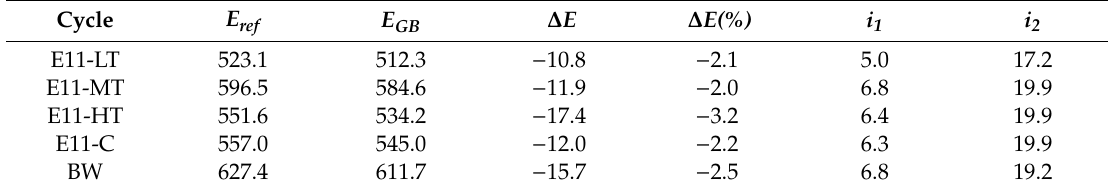
Figure 9. Illustration of optimal gear ratio selection policy for the CVT ( a ) and the two-speed gearbox with five second minimum gap between changes ( b ). The speed profile is a 200 second section from the E11-LT driving cycle. Table 4. Energy consumption advantage achieved with the two-speed gearbox in five driving cycles. All energy consumption related numerical values are reported in units of Wh / km.